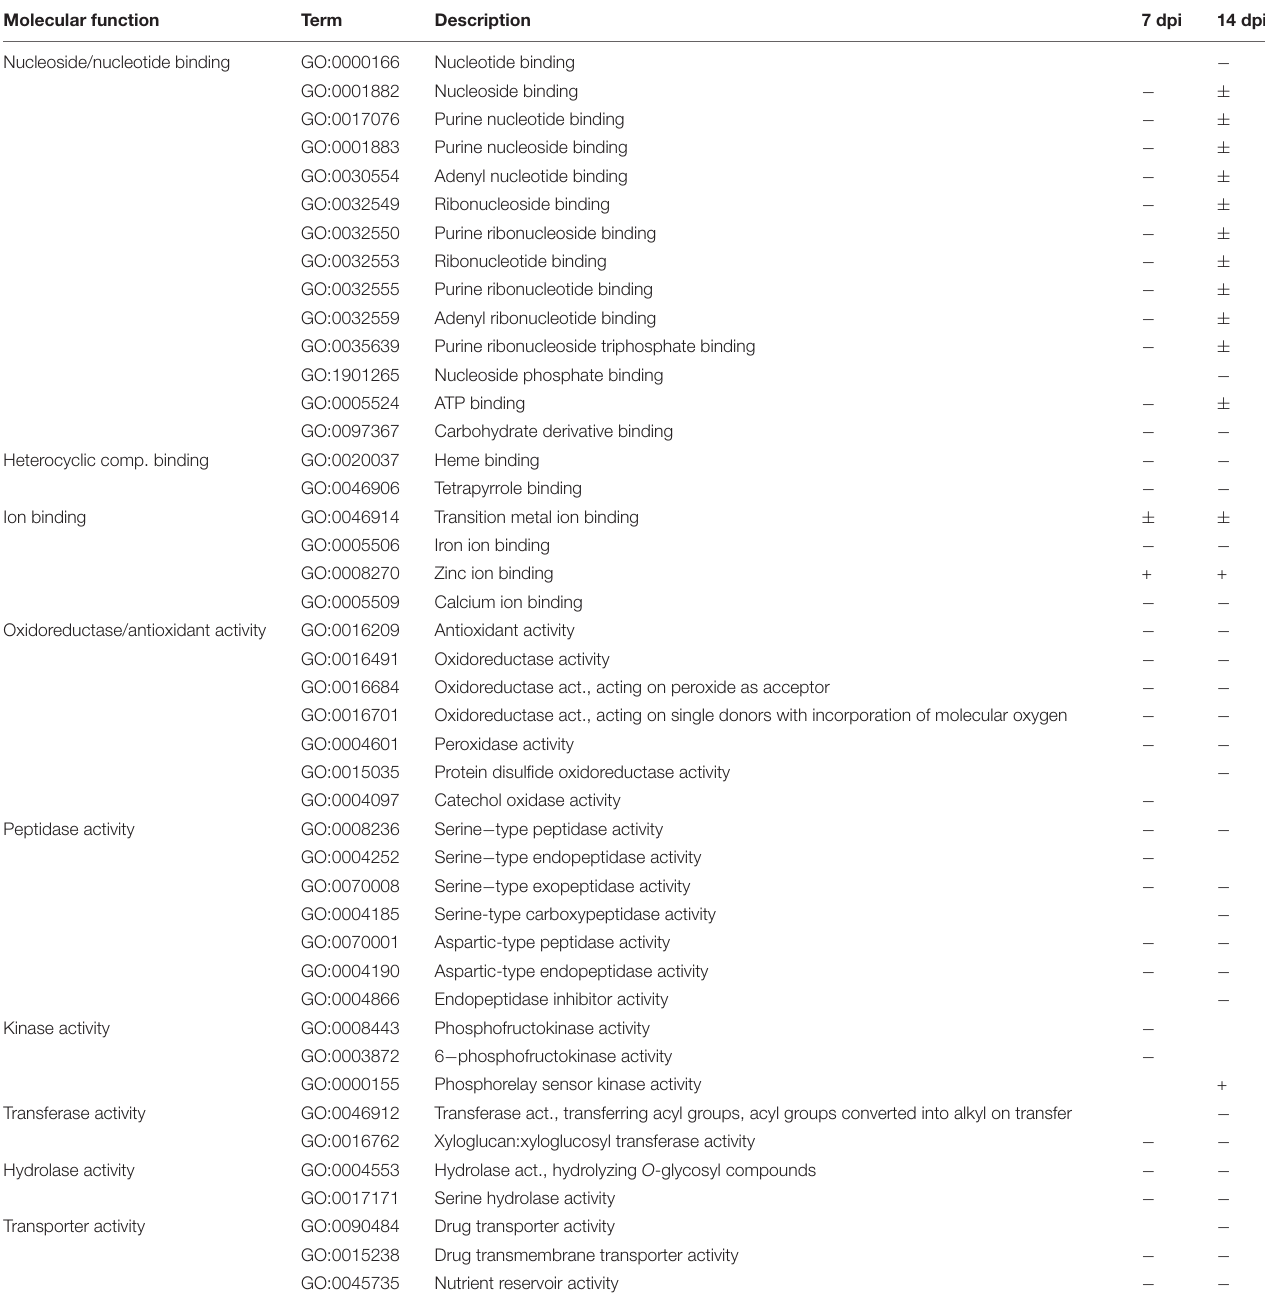
TABLE 2 | Gene Ontology (GO) analysis summary: molecular functions were enriched ( p -value ≤ 0.05) for differentially expressed genes (DEGs) during water stress and M. incognita infection (RKN_WS vs. C) at 7 and 14 dpi. Molecular function Term Nucleoside/nucleotide